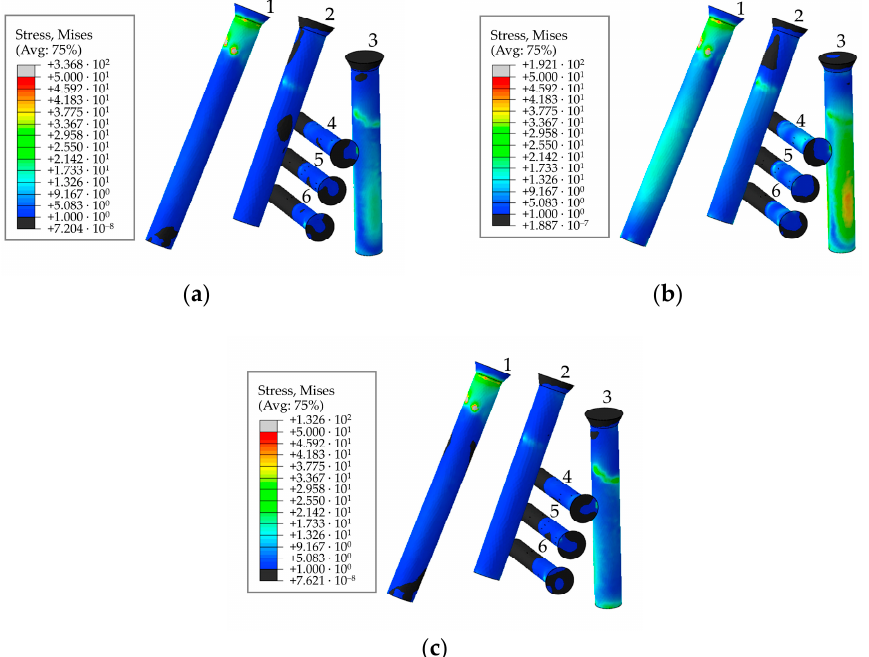
Figure 24. Stress distribution for a pretension force of 50 N and the screw numbering convention in the screws in maximum loading phases corresponding to: ( a ) walking; ( b ) ascending stairs; ( c ) descending stairs, MPa.